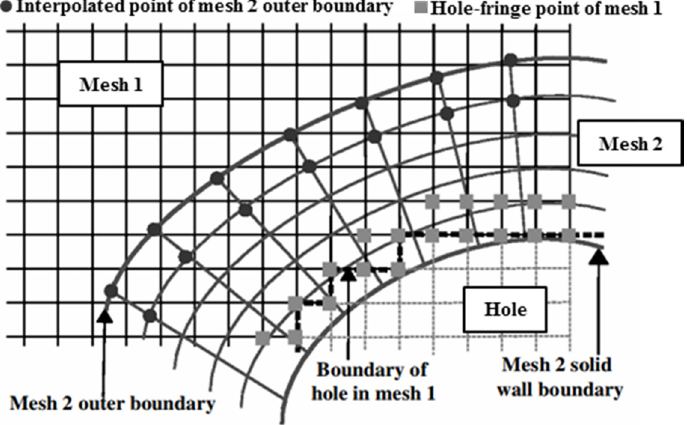
Figure 2. Details of the overset mesh.